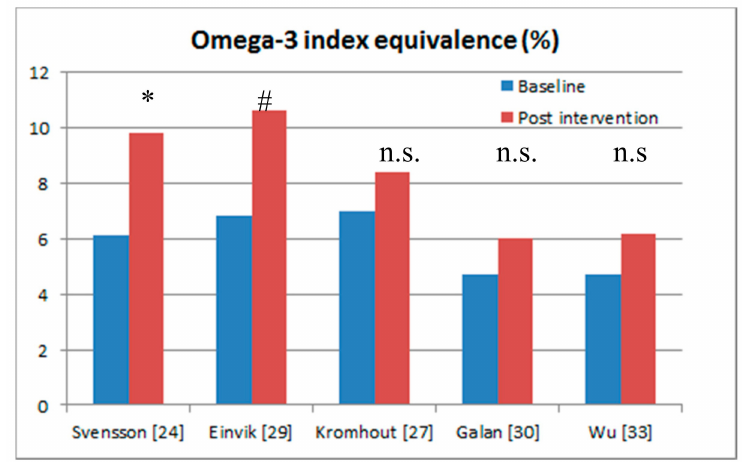
Figure 2. Randomised controlled trials of the effects of omega-3 supplementation that included blood sampling at baseline and post-intervention. * Significant effects ( p < 0.05); # only 140 per group